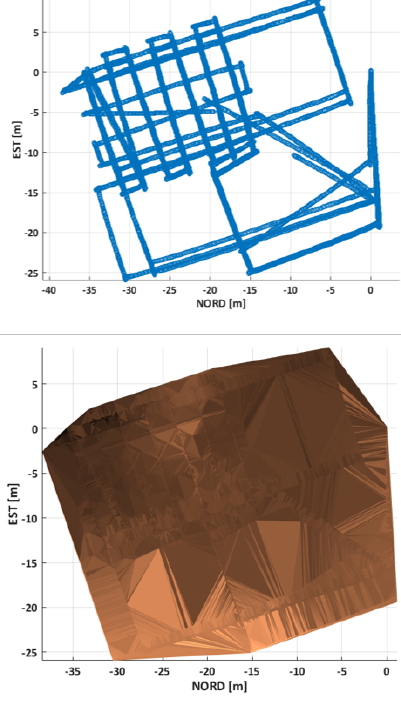
Figure 3. First recorded path (top) and original 3D mesh (bottom) Figure 4. Multiple recorded paths (top) and 3D mesh from BW algorithm application